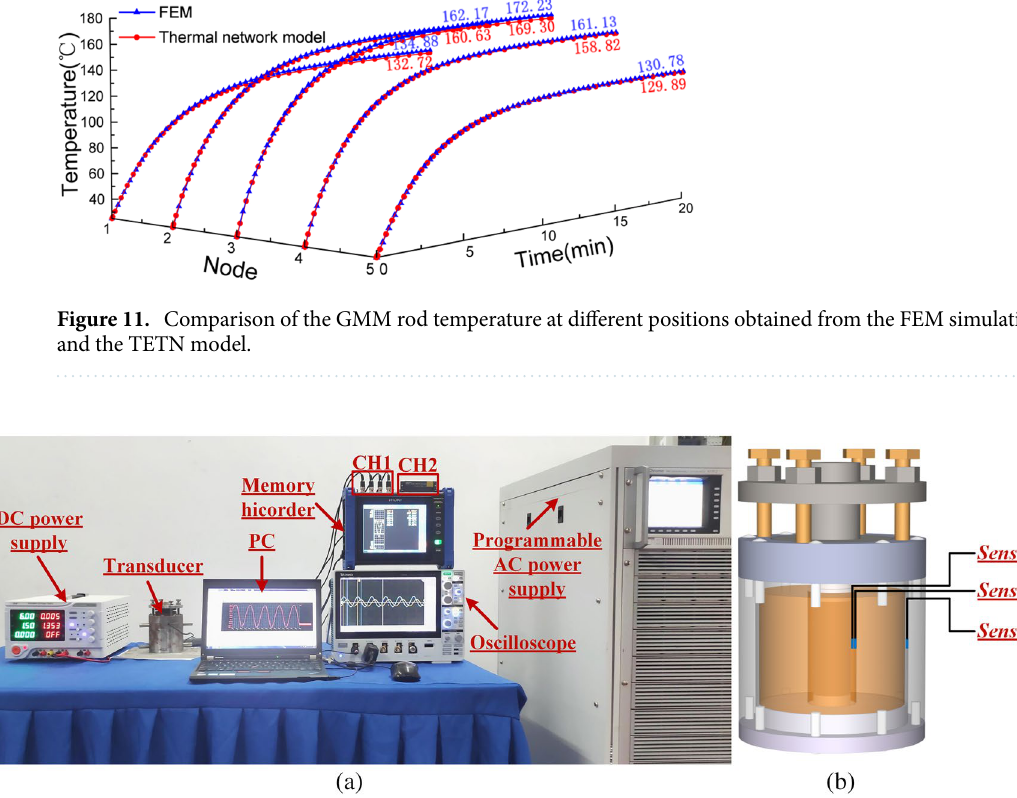
Figure 12. Temperature rise experimental platform for longitudinal vibration GMT: ( a ) Experimental platform, ( b ) Selected test